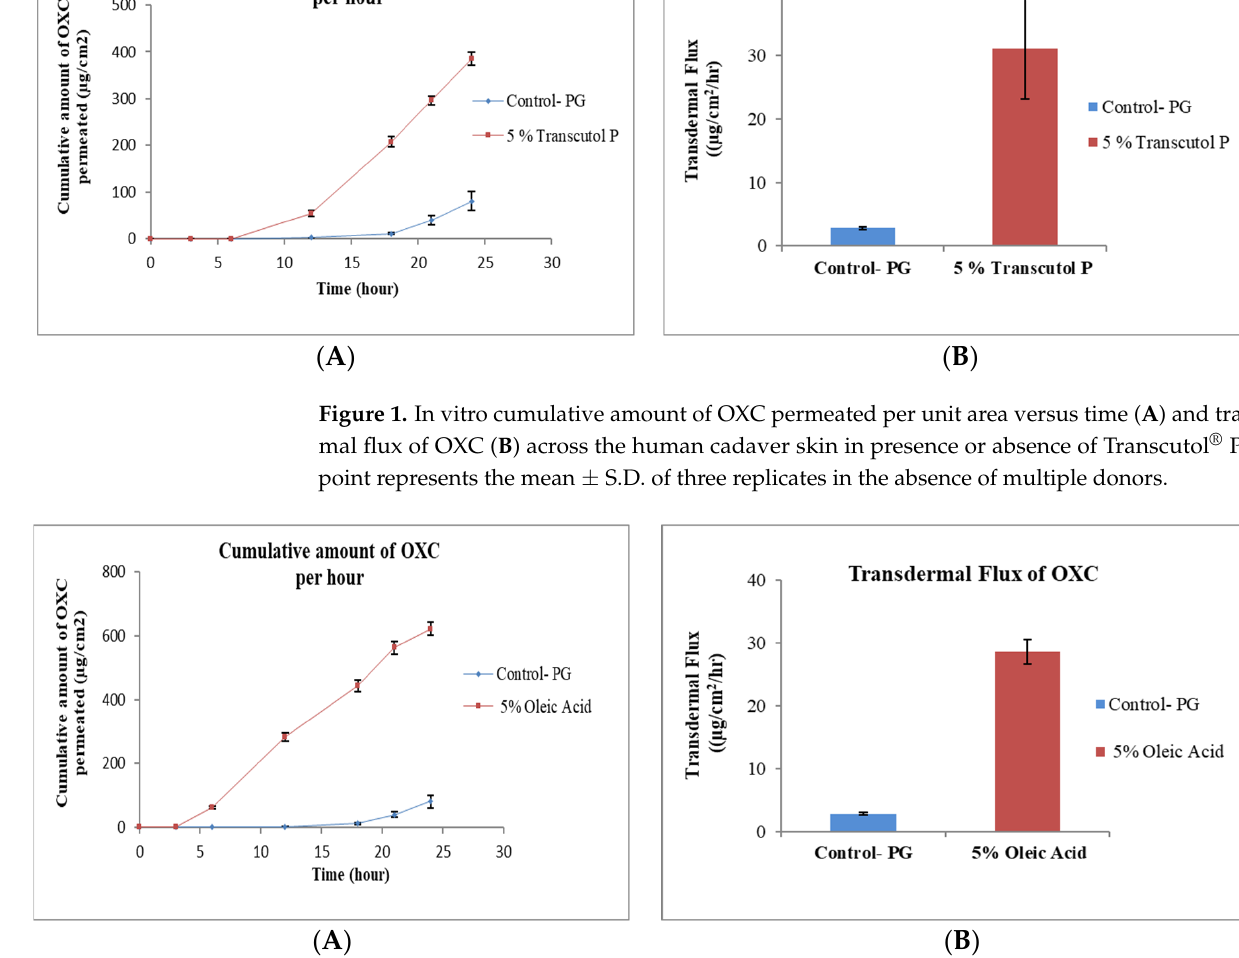
Figure 2. In vitro cumulative amount of OXC permeated per unit area versus time ( A ) and transdermal flux of OXC ( B ) across the human cadaver skin in presence or absence of oleic acid. Each point represents the mean ± S.D. of three replicates in the absence of multiple donors.